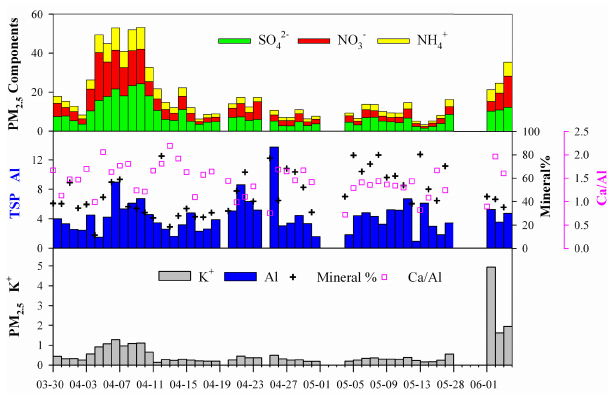
Fig. 6. Time series of (a) SO 42- , NO 3- , and NH 4+ concentration ( μ gm -3 ) in PM 2.5 (b) Al concentration ( μ gm -3 ), the fraction of mineral aerosol, and the elemental ratio of Ca/Al in the total suspended particles (TSP) (c) K + in PM 2.5 , during the whole study period (Missing data were due to rainfall or malfunction of instruments).